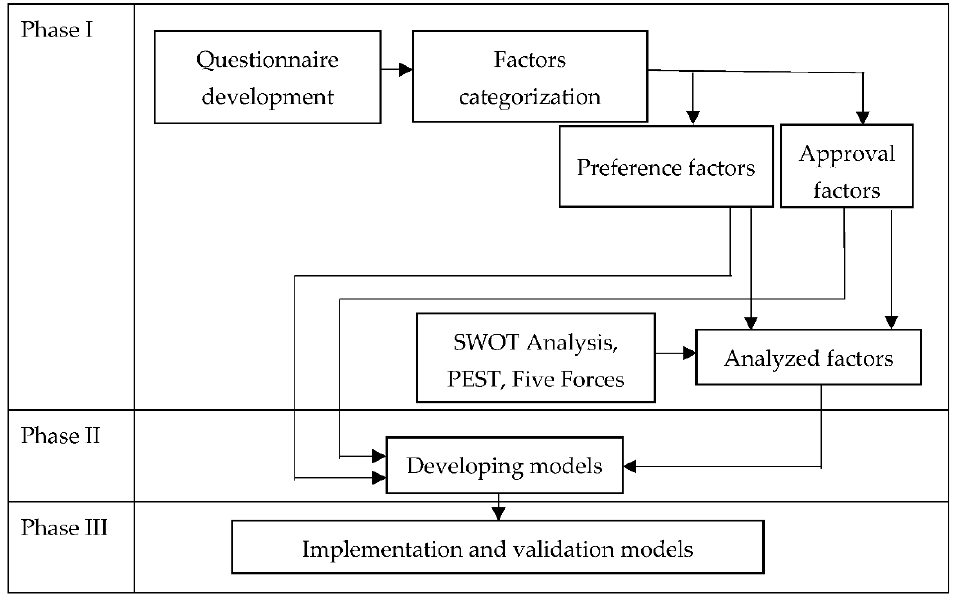
Figure 2. Research